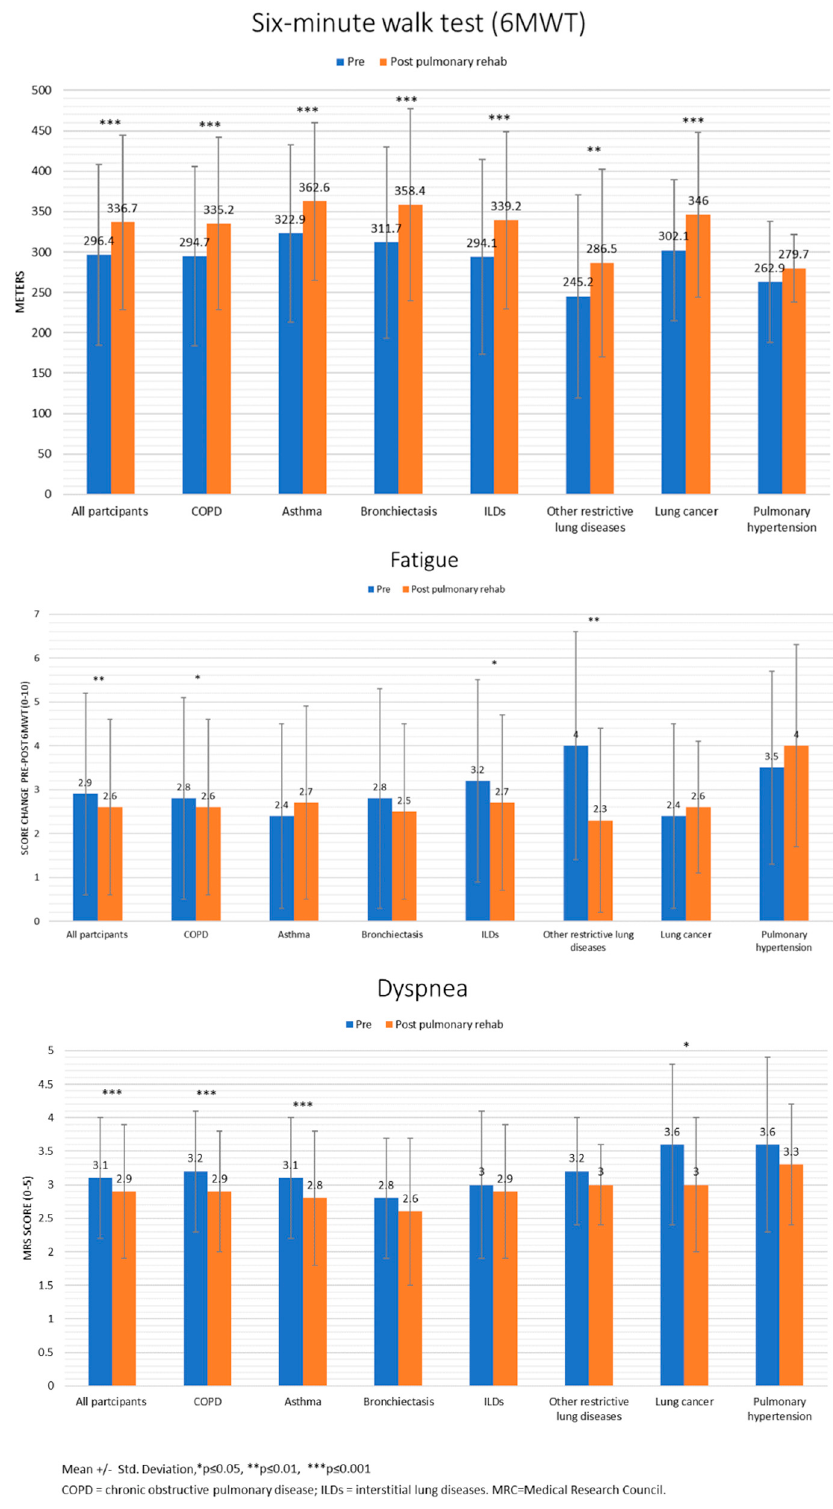
Figure 1. Exercise capacity pre-post Pulmonary Rehabilitation program.